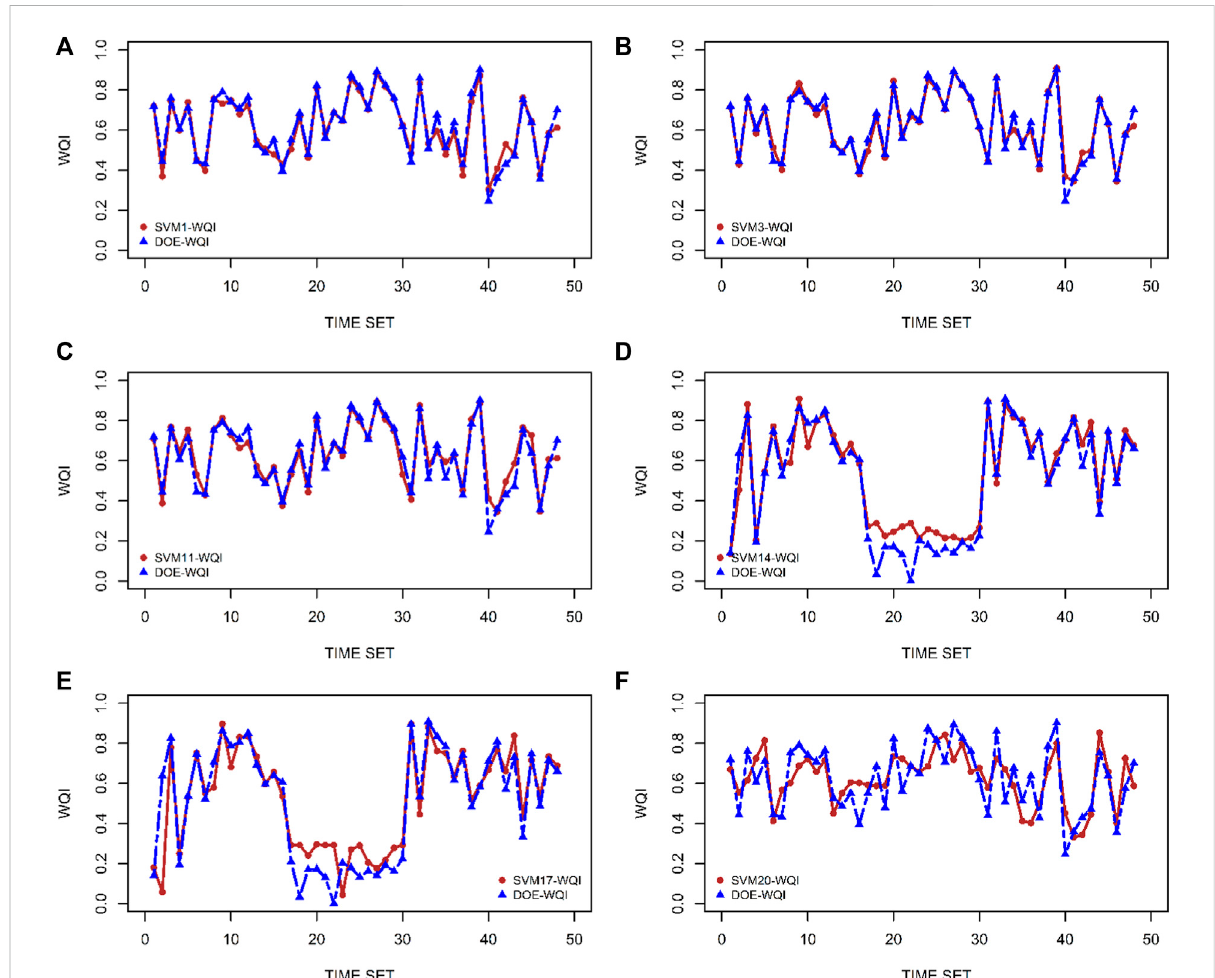
FIGURE 3 Comparison of the observed (DOE-WQI) and the best predicted model (SVM-WQI) for each scenario: (A) SVM1-WQI; (B) SVM3-WQI; (C) SVM11-WQI; (D) SVM14-WQI; (E) SVM17-WQI; and (F) SVM20-WQI.